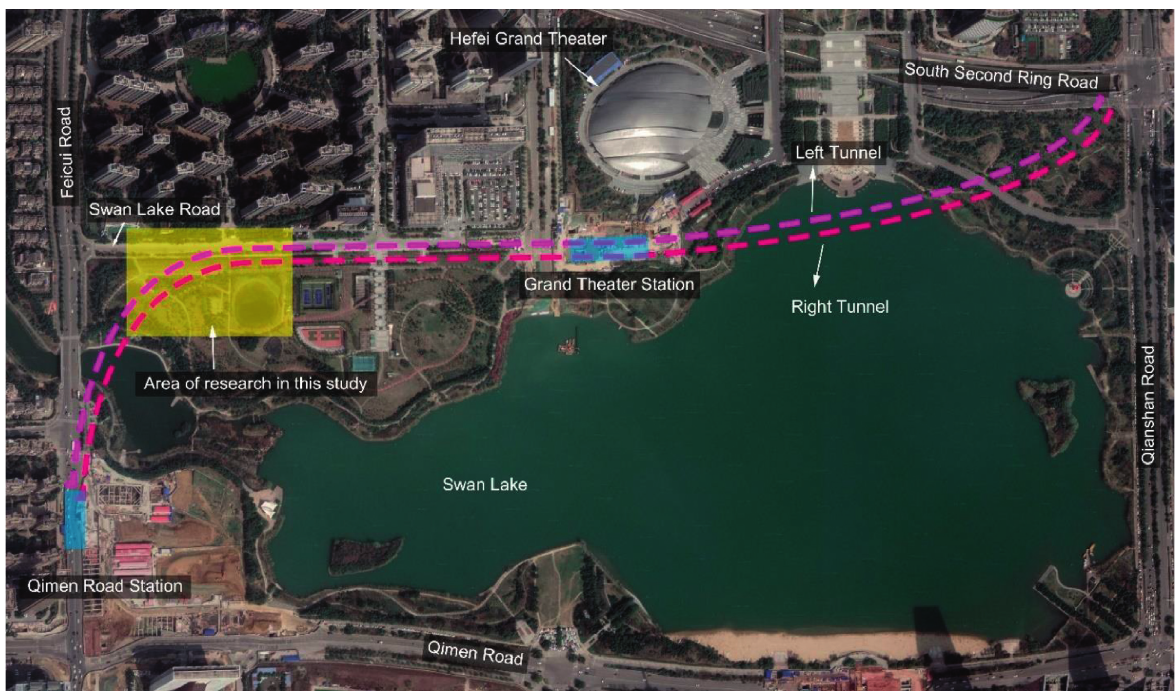
Figure 1: A map for the location of the considered case history.